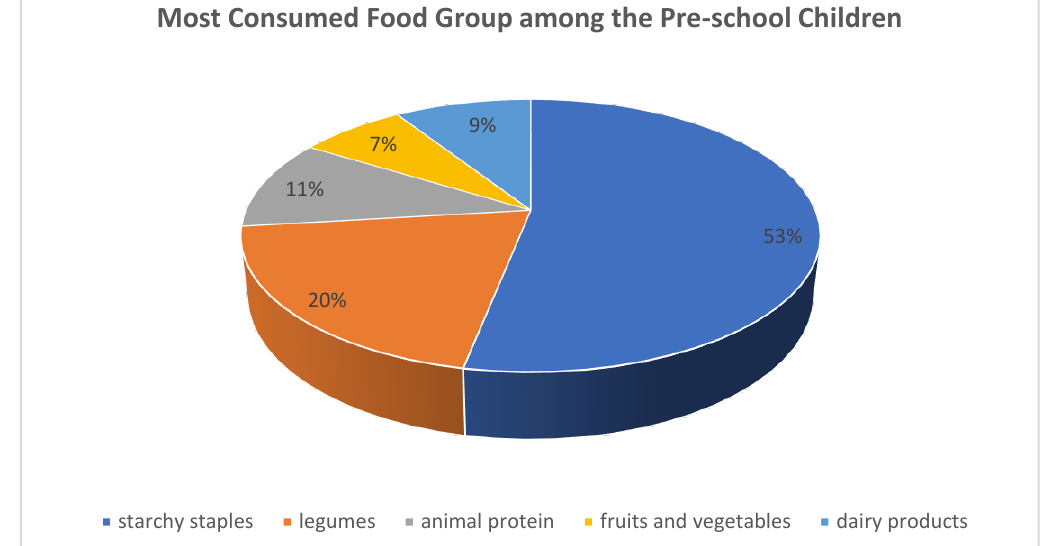
Figure 3. Most consumed food group by the preschool children in Niger State, Nigeria. Fruit and vegetable consumption was very insufficient among the preschoolers. The number of children who met their minimum dietary diversity (MDD) and MMF was low compared with those not meeting theirs, as indicated in Figure 4, which is not consistent with the findings of Ahmed et al. [46], who reported that the majority (61.7%) of the children met their MMF, while 42.5% met their MDD.